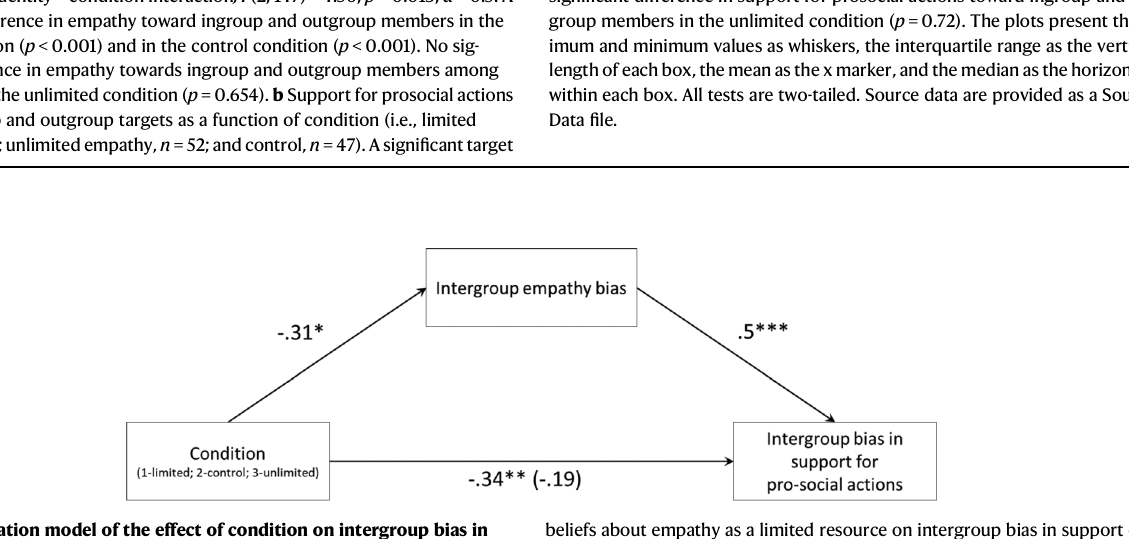
beliefs about empathy as a limited resource on intergroup bias in support of pro- social actions. * indicates p <0.05, ** p <0.01, *** p <0.001. All tests are two-tailed. Source data are provided as a Source Data fi